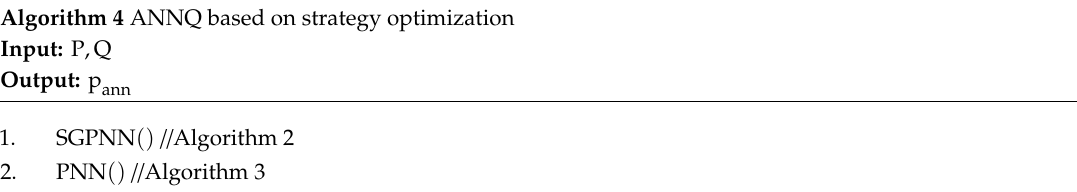
Algorithm 4 ANNQ based on strategy optimization